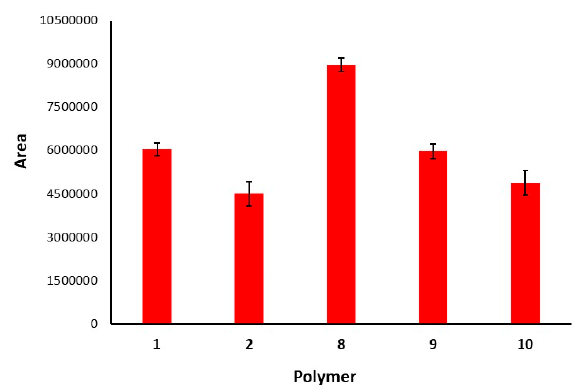
Figure 4. Comparison of the analytical signal (area) of norepinephrine, after the rotary disk sorption extraction technique (RDSE) microextraction, using polymers 1, 2, 8-10 as sorbents, in artificial urine fortified at 1000 μ gL − 1 .